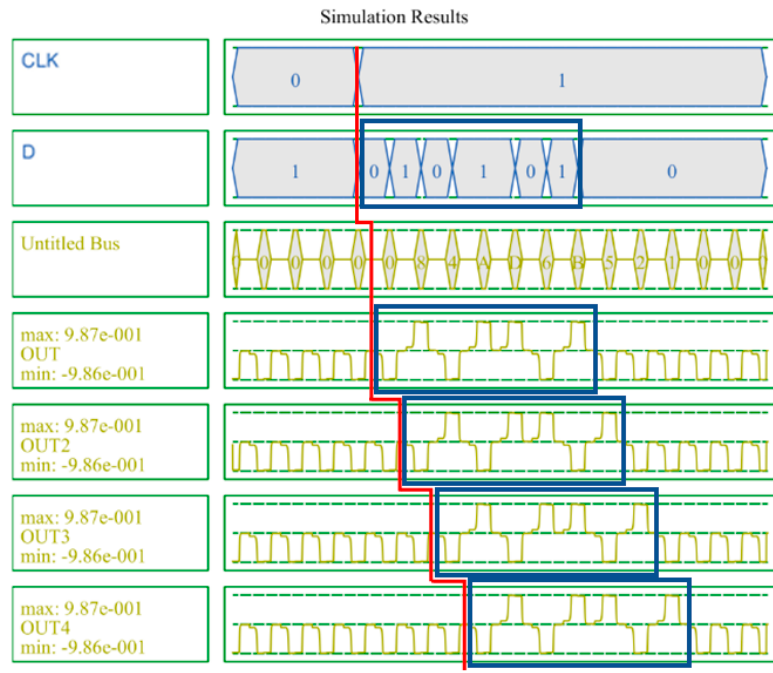
Figure 17. Simulation result of the proposed 4-bit SR.